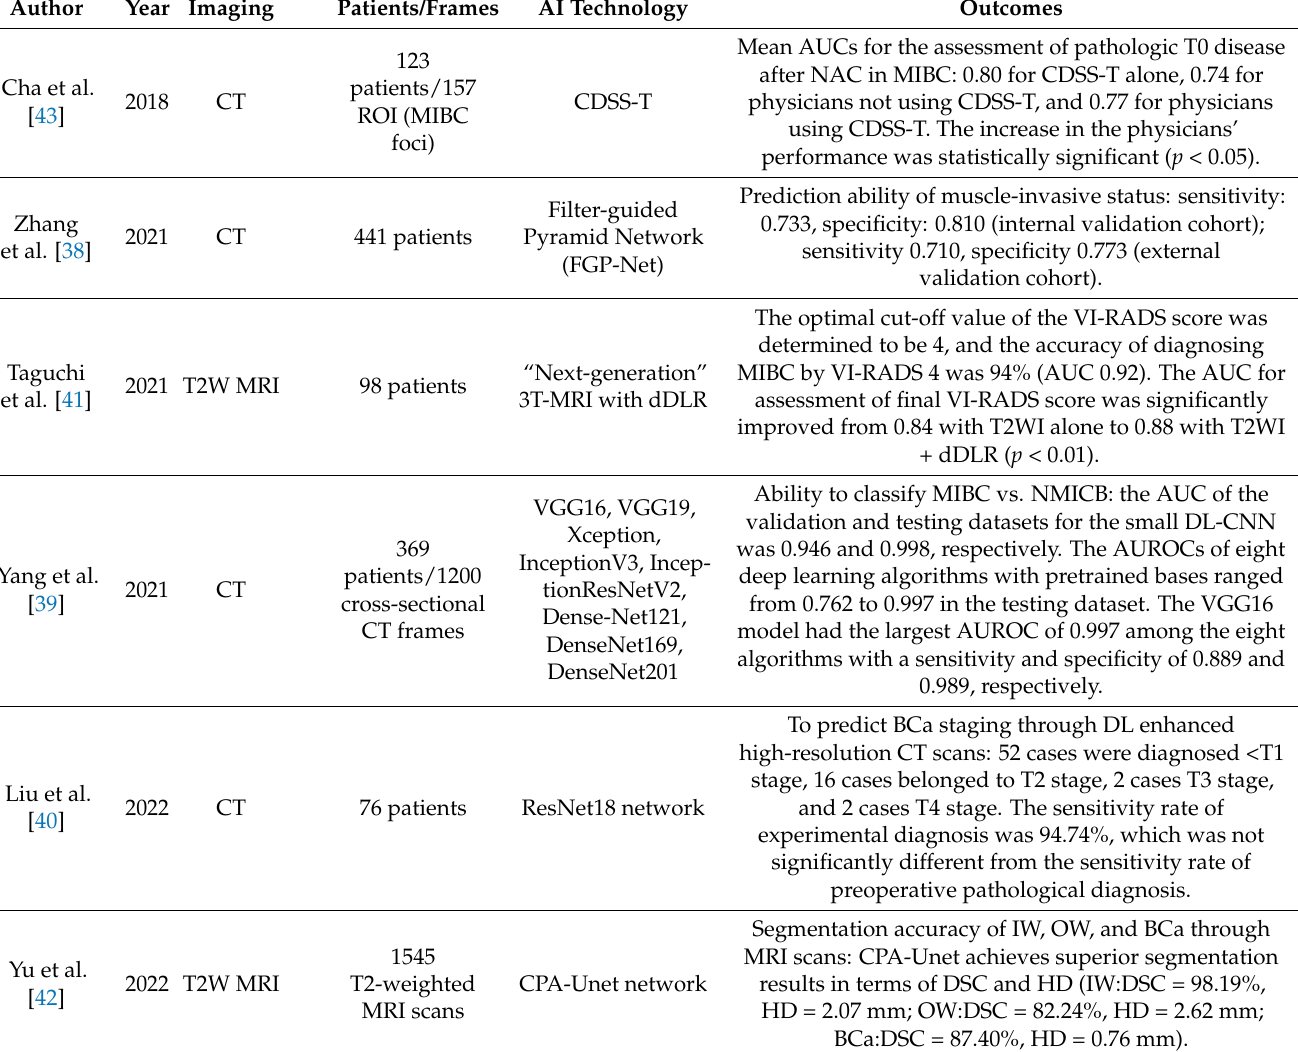
Table 2. Deep learning approach applied to diagnostic